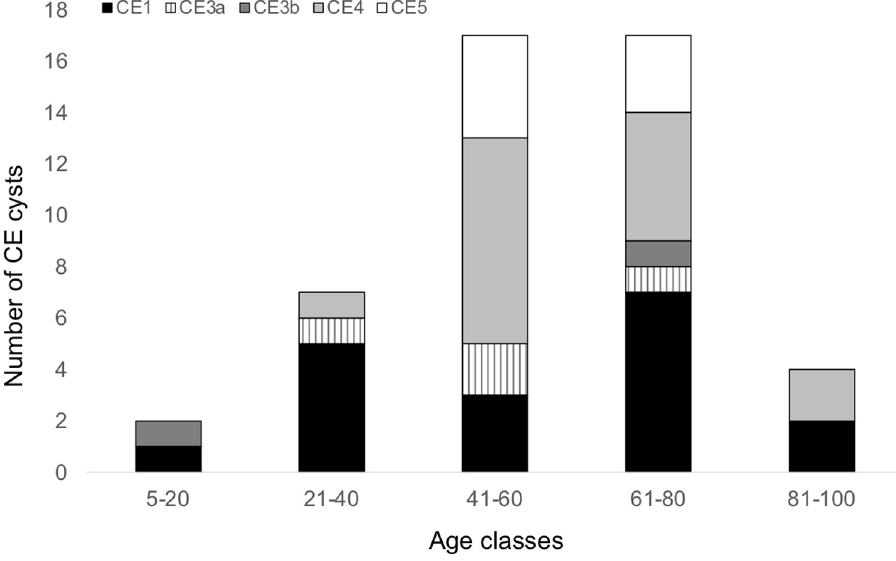
Fig 5. Distribution of the abdominal cystic echinococcosis cyst stages (47 cysts detected in 39 cases) according to the WHO Informal Working Group on Echinococcosis (WHO-IWGE) classification by age classes. Monte Patria municipality, Limarı´province, Coquimbo region,